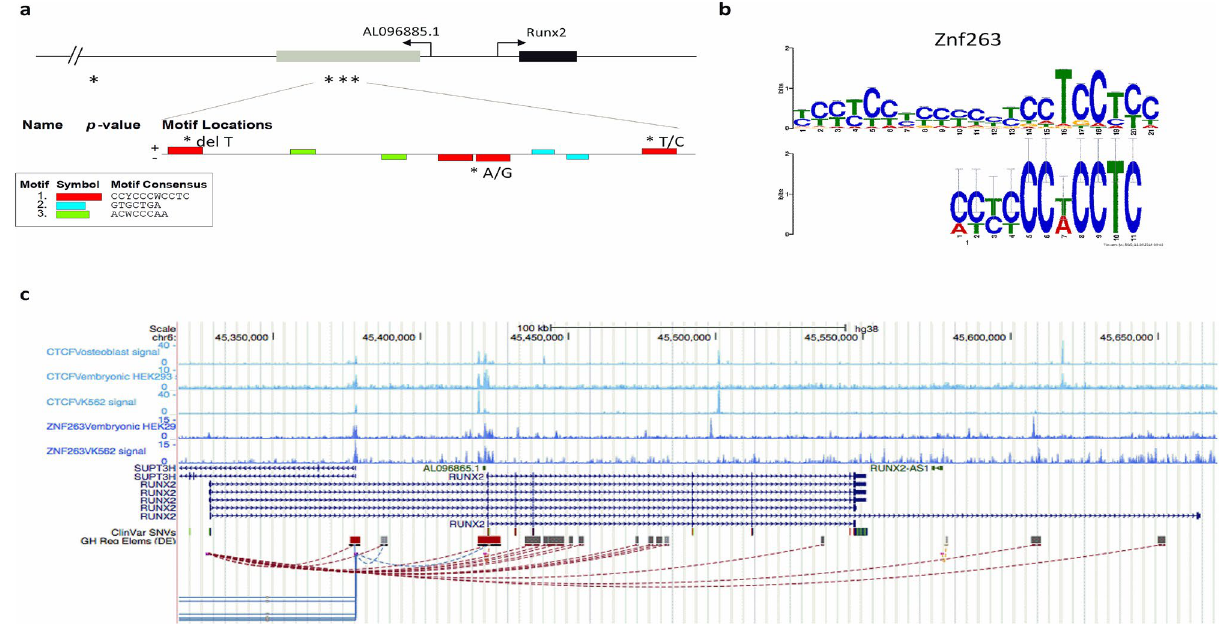
Figure 3. Genomic variants in RUNX2 P2 promoter overlap with ZNF263 binding sites at CTCF-mediated loop anchor regions. (a) Motif analysis using MEME suite of the P2 proximal promoter region, containing a cluster of three nucleotide variants in AMHs compared with Denisovan/Neandertal species (chr6:45,421,398–45,421,567), identified three CCY CCC WCCTC motifs overlapping with the three genomic variants. (b) In silico analysis using Tomtom identified ZNF263 as a transcription factor binding the CCY CCC WCCTC motif. (c) Scheme of the RUNX2 locus (Chr6:45,318,000–45,670,000 GRCh38/hg38) showing the different RUNX2 isoforms and regulatory regions and available Encode data. These include: ChIP-seq tracks (fold change over control) for CTCF binding (light blue) in osteoblasts, HEK293 and K562 cell lines, ChIP-seq tracks (fold change over control) for Znf263 binding (dark blue) in HEK293 and K562, short nucleotide clinical variants ClinVar SNVs and GeneHancer regulatory elements (GH Reg Elem (DE)), including 3D chromatin loop